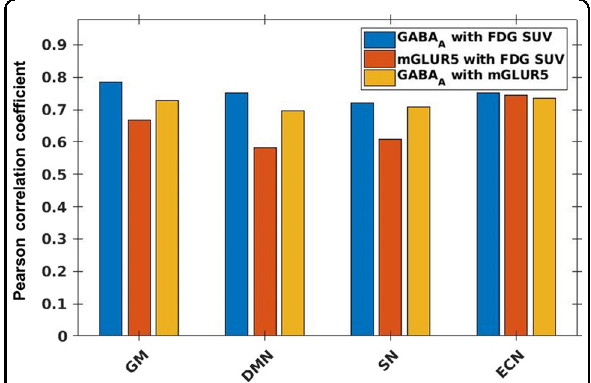
Fig. 6 Correlation values between PET measures. Bar plot showing Pearson correlation coef fi cient values calculated between receptor availability of GABA A with FDG-PET SUV (blue bars), receptor availability of mGluR5 with receptor availability of GABA A (red bars), and receptor availability of GABA A with receptor availability of mGluR5 (yellow bars). The correlation values are shown for the whole-brain grey matter region (GM), the default mode network (DMN), the salience network (SN) and the executive control network (ECN).